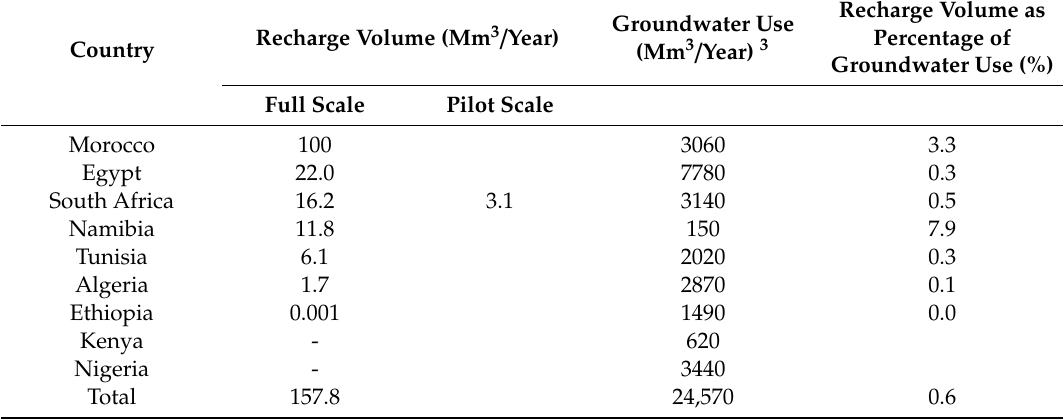
Table 4. Recharge volume per country and recharge as percentage of groundwater use, arranged by recharge volume, where information is available (n =